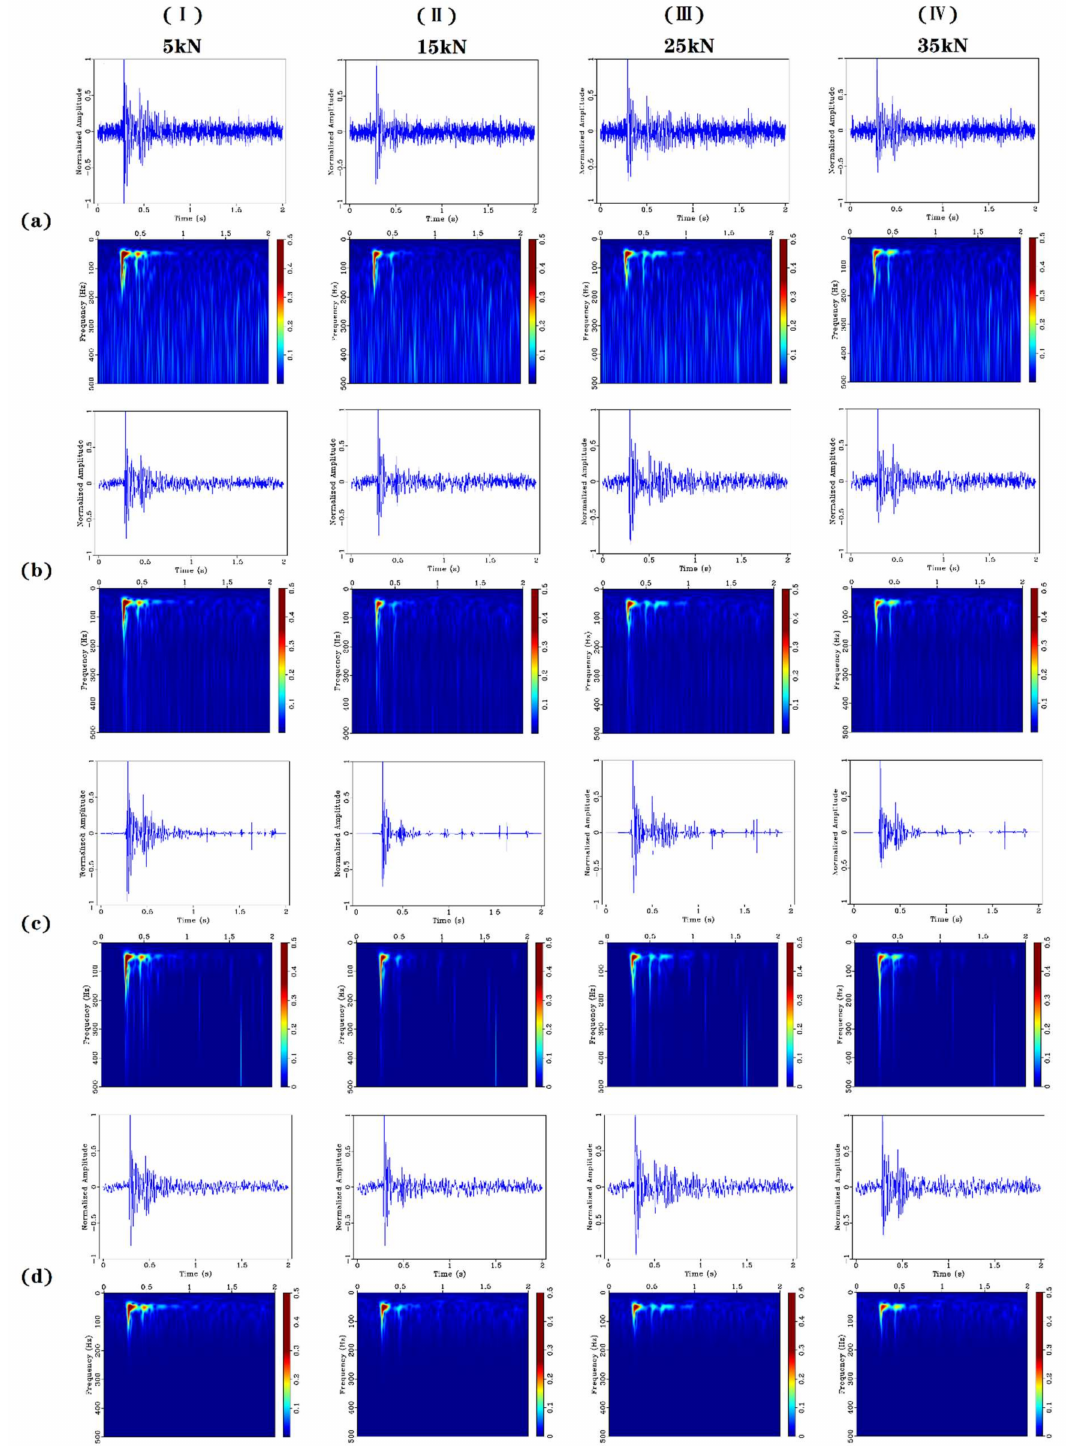
Figure 9. Time domain signals and corresponding time-frequency domain results for each loading stage for Accelerometer 1: Columns ( I to IV ) show the loading stage and the rows correspond to the filtering technique: ( a ) Spectrum for original signal; ( b ) median filtering result; ( c ) wavelet denoising result and ( d ) bilateral filtering